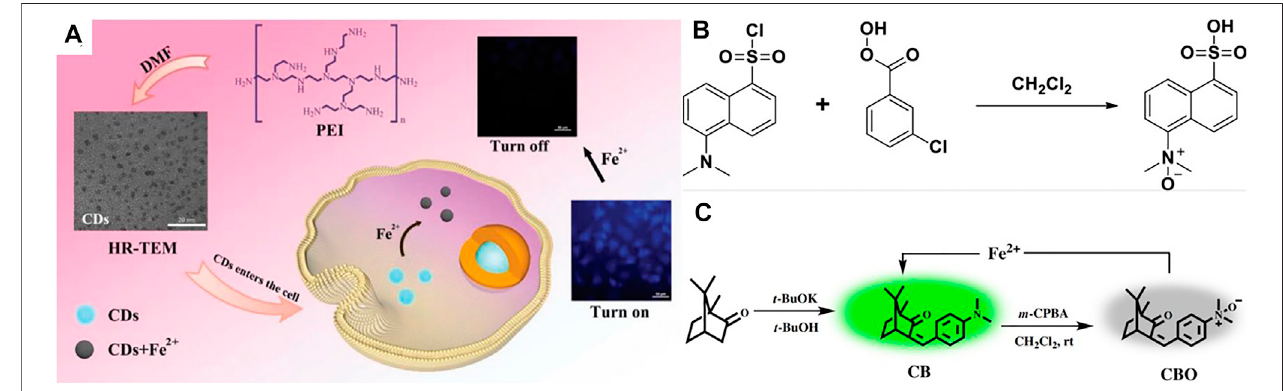
FIGURE4|(A) One-pothydrothermalsynthesisof fl uorescentCDsasahighlyef fi cient “ on-off ” fl uorescentprobefortherapiddetectionofintracellularFe 2+ (Zhang X. et al., 2020); (B) The synthesis route of probe FeP1 (Khatun et al., 2020); (C) The synthesis route of probe CBO (Liang et al.,